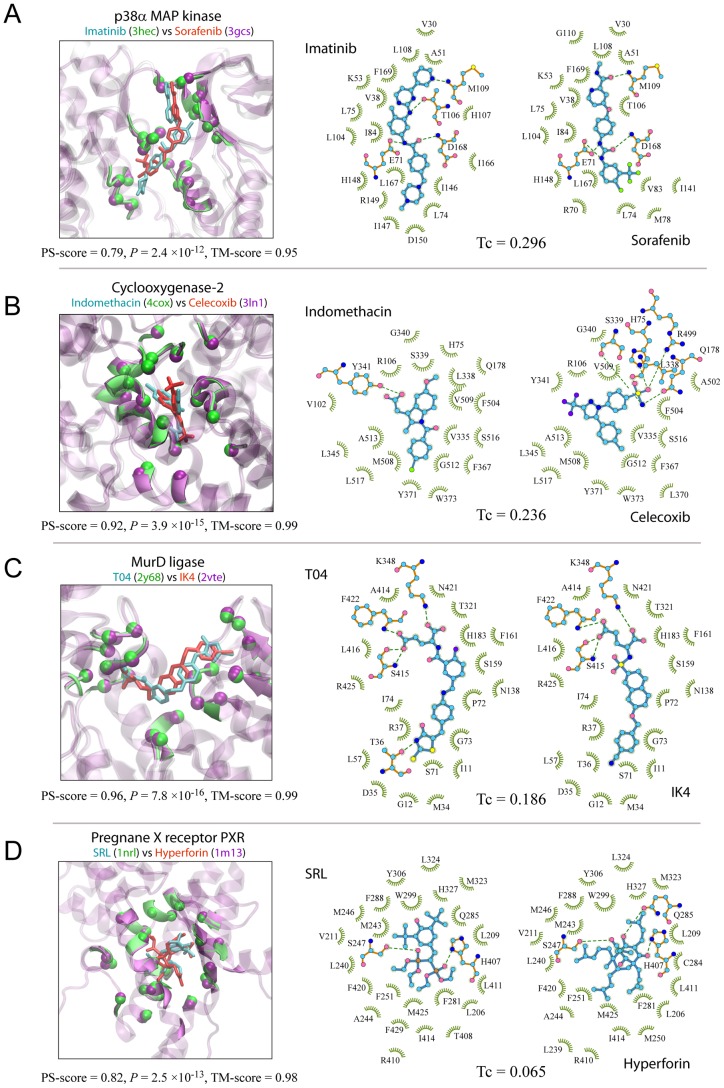
Four examples of promiscuous pockets recognized by ligands of different chemical structures.(A–D) Each panel is composed of three snapshots. On the left is the APoc superimposition of the same protein pockets separately in complex with two ligands. The representation is the same as in Fig. 1. Labels of ligands and PDB codes (in parentheses) are in the same color scheme as their 3D images. On the middle and right are the schematic 2D views of the two ligands and their respective interacting pocket residues. Ligands are shown in a stick and ball representation. Protein residues that form hydrogen bonds are also shown in a stick and ball representation, and other contacting residues are shown in a green eyelash representation. In the stick and ball representation, carbon, oxygen, nitrogen, phosphorus, sulfur, chlorine, fluorine atoms are shown as cyan, red, blue, brown, yellow, green, purple balls, and covalent bonds in the ligand and protein are shown in cyan and orange sticks. Hydrogen bonds are indicated by green dashed lines, with their lengths (all less than 3.35 Å) not drawn to scale. Amino acids are labeled by their one-letter code followed by their residue index in the original PDB records, except for 4cox in (B), whose residue indexes are renamed to be consistent to 3ln1 for clarity. Diagrams of ligand-protein interactions were created with the program LigPlot+ [57].